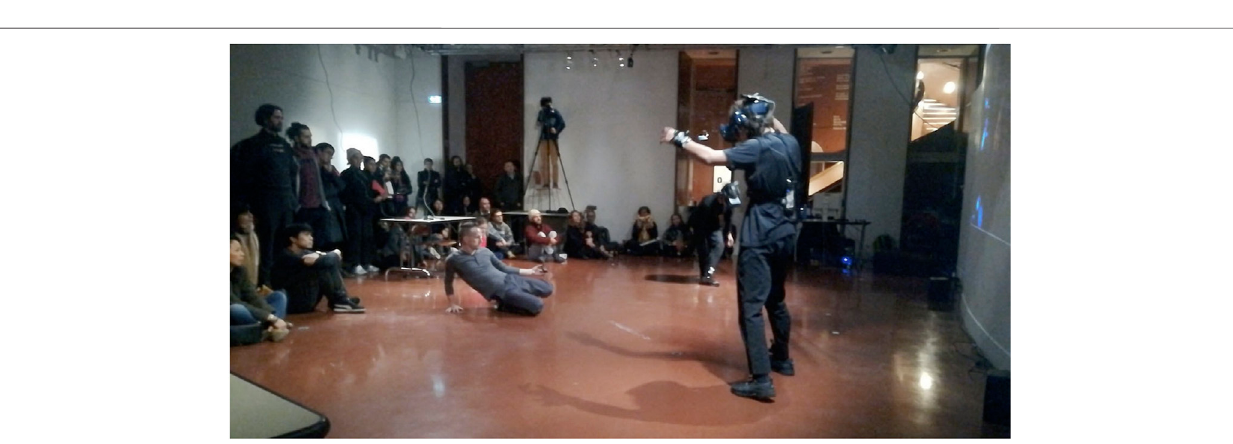
Frontiers in Virtual Reality |